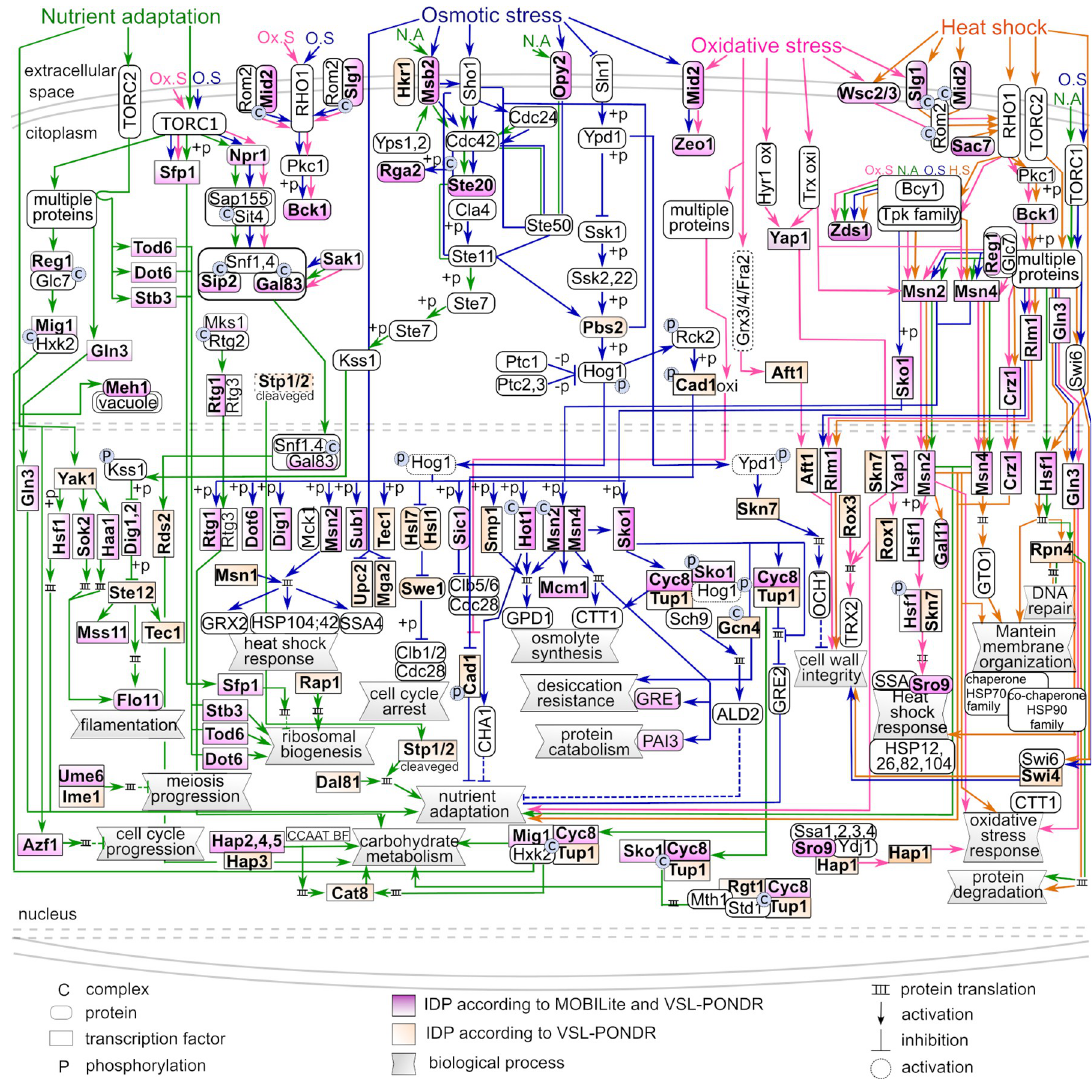
Fig 3. Stress signaling pathways in S . cerevisiae . Intrinsically disordered transcription factors (IDTFs) (boxes) and other signaling IDPs (ovals) identified with MobiDB are highlighted in violet. The nutrient adaptation, osmotic stress, oxidative stress and heat shock signaling pathways are marked with lines and arrows in green, blue, pink and orange, respectively. Signaling proteins showing lower structural disorder but filtered through VSL2 were also included in this figure (orange boxes and ovals). Stress response signaling pathways were modified from Kawakami et al.